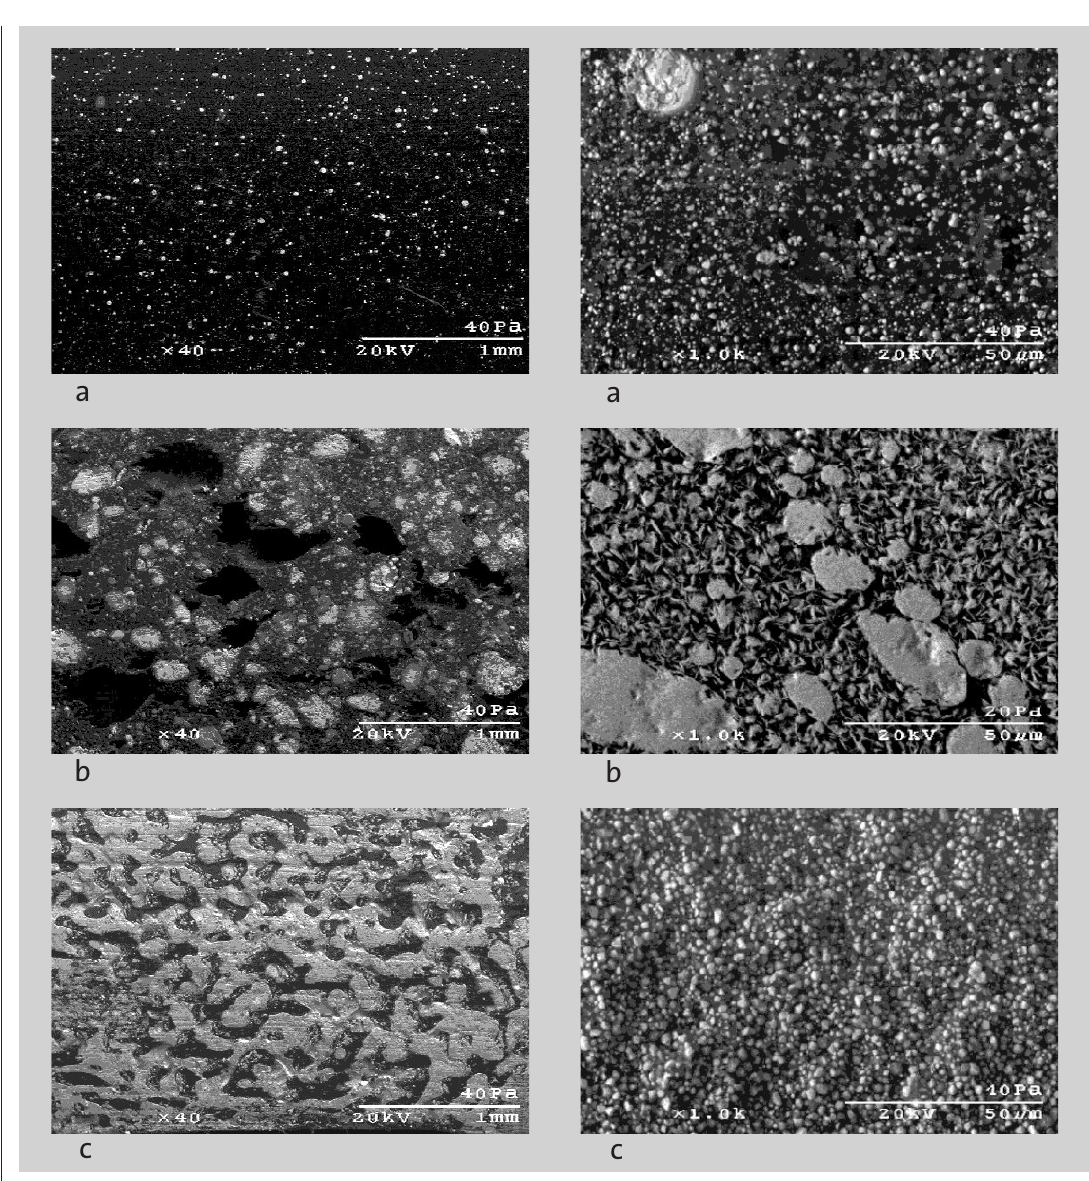
Fig. 7 (left) : SEM micrographs of (a) 10 vol% , (b) 30 vol%, and (c) 50 vol% Pglass-LDPE hybrids. Fig. 8: SEM micrographs of (a)10 vol% , (b) 30 vol%, and (c) 50 vol% Pglass-PS